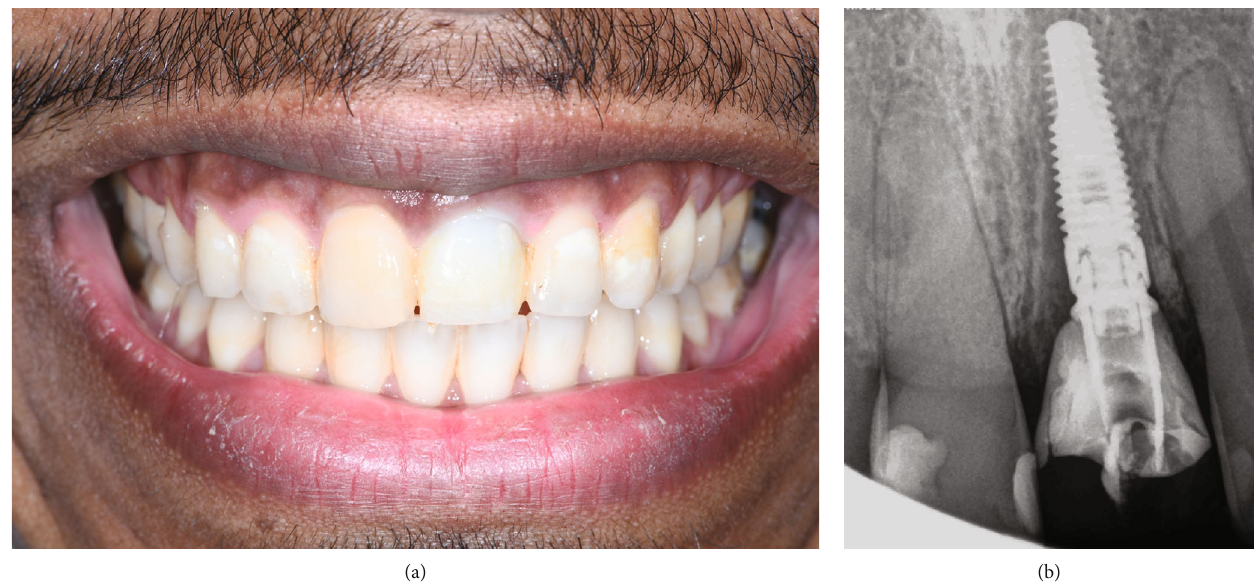
Figure 5: Clinical and radiographic presentation of the immediately placed implant with provisional restoration for tooth #21. (a) Intraoral frontal view. (b) Periapical radiograph.